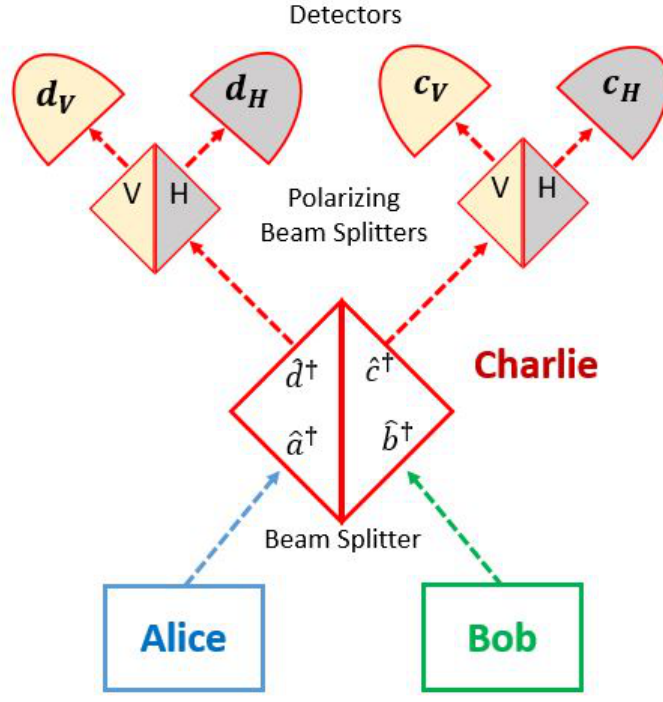
Figure 1. Diagram of MDI-QKD